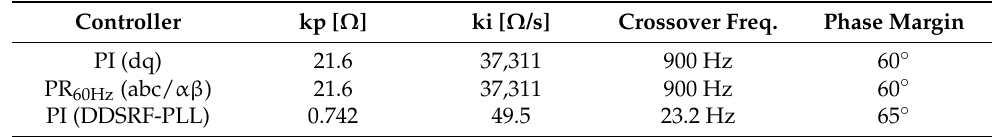
Table 1. Parameters of PLL and current